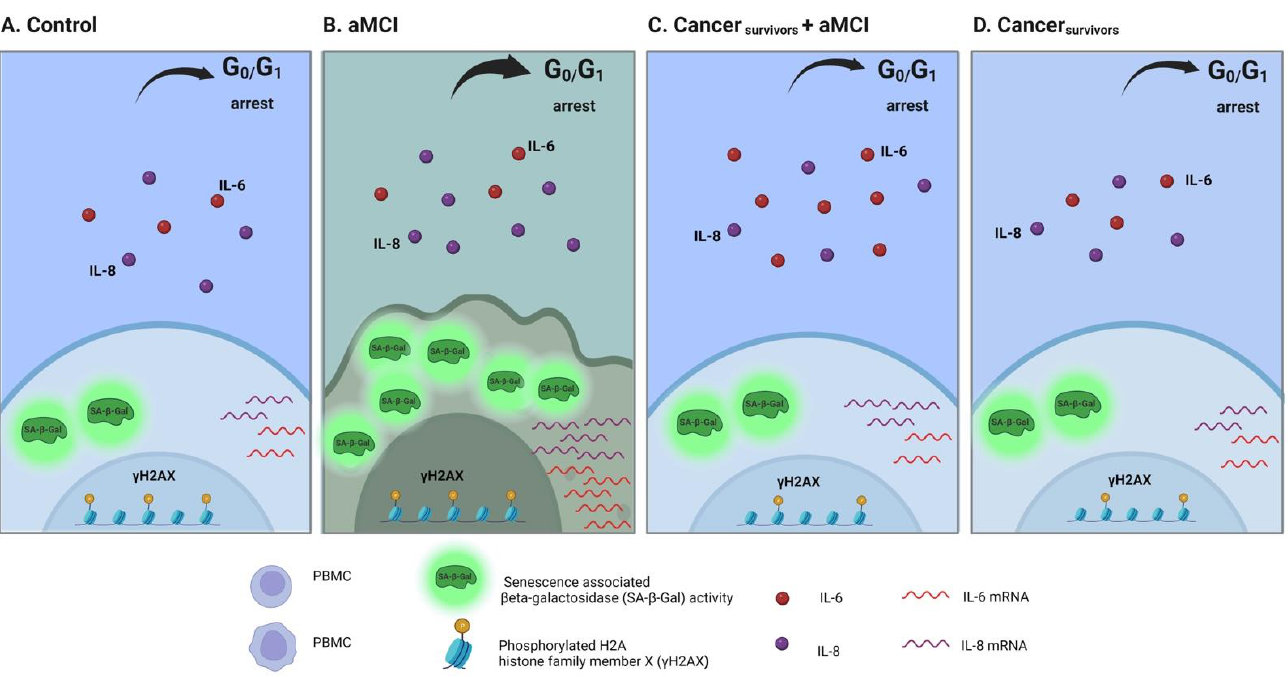
Figure 1. Schematic representation showing that a history of cancer avoids the increase of senescence markers in PBMCs of aMCI patients. The figures represent PBMCs of healthy controls ( A ), aMCI ( B ), Ca + aMCI ( C ), and Ca survivor ( D ) patients. Panels A and B represent the results reported in [27]. Senescence markers SA-β-Gal, Go-G1 arrested cells, IL-6 and IL-8 mRNA expression, and IL-8 plasmatic levels, which were elevated in PBMCs of aMCI patients, were decreased in those of Ca + aMCI to levels as those of controls or of cognitively normal cancer survivors.